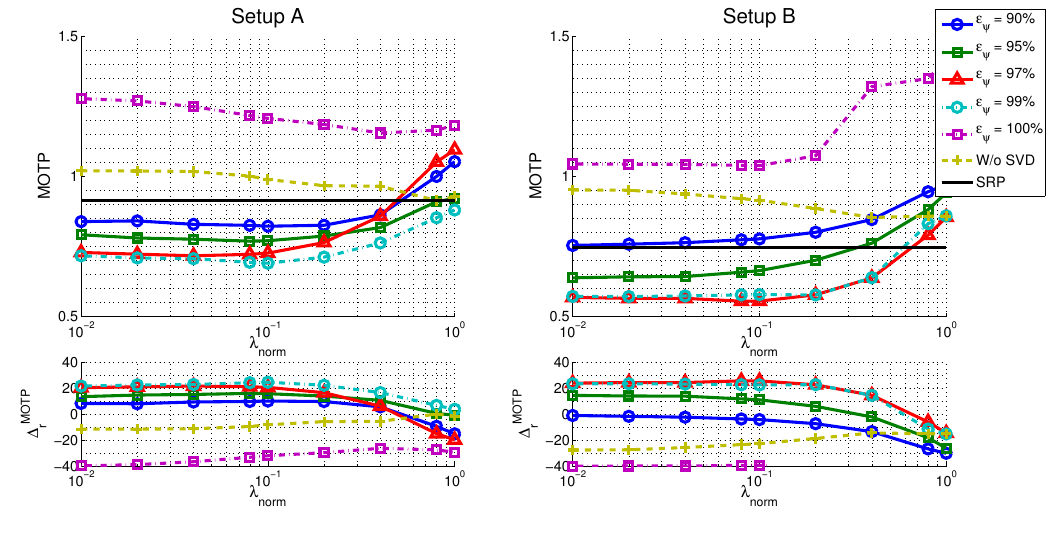
Figure 9. Optimization results for MOT P and relative improvements as a function of λ and e , for microphone setups A and B on sequence seq01 . The black trace is the baseline ψ SRP-PHAT